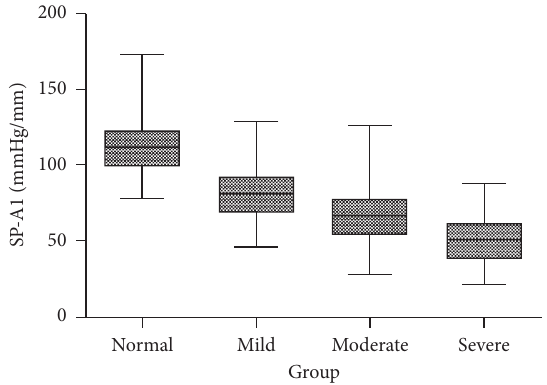
Figure 1: Distribution of SP-A1 in normal and keratoconus